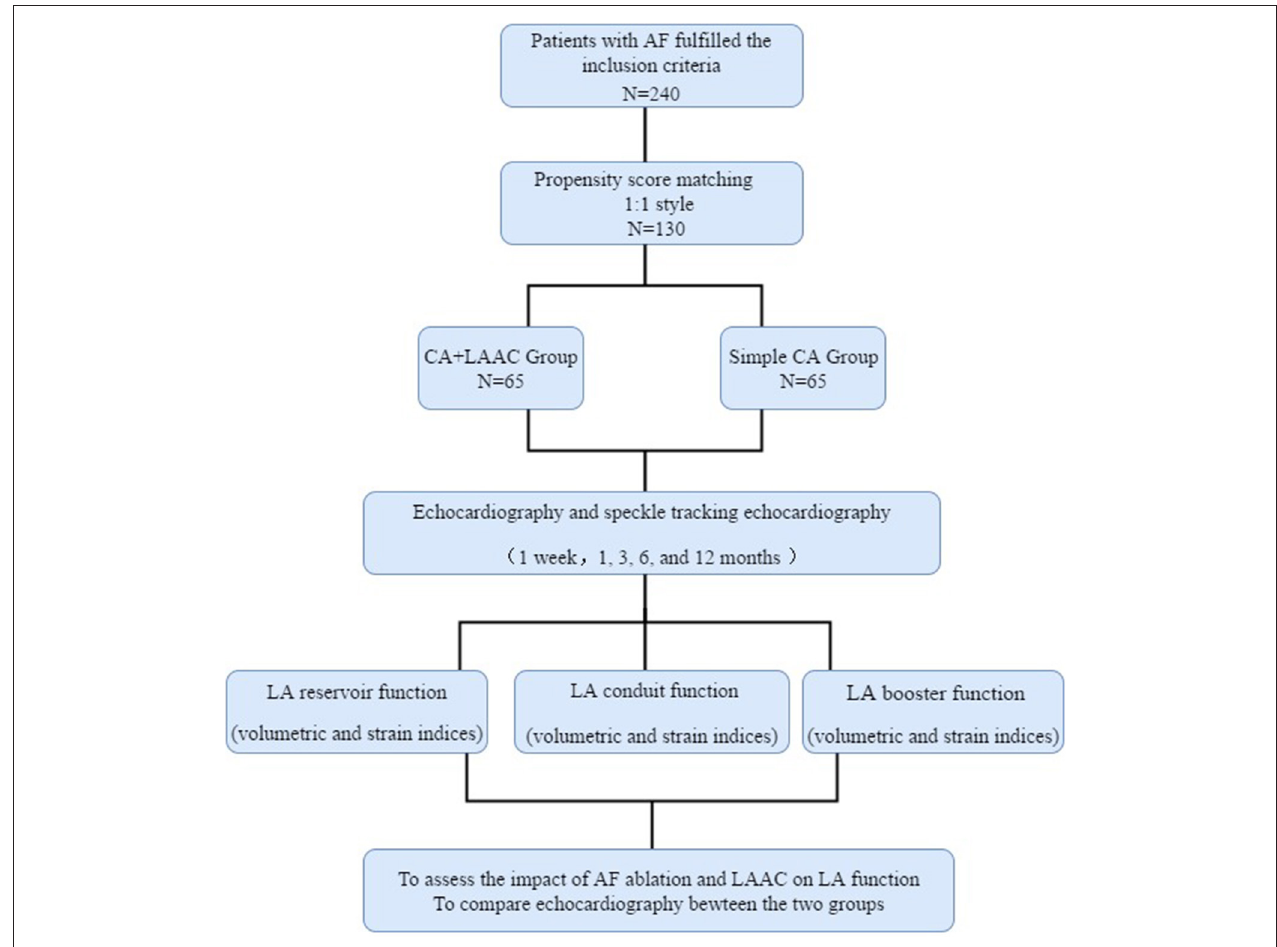
FIGURE 1 | Flowchart of the study procedure. LA, left atrial; LAAC, left atrial appendage closure; CA, catheter ablation; AF, atrial